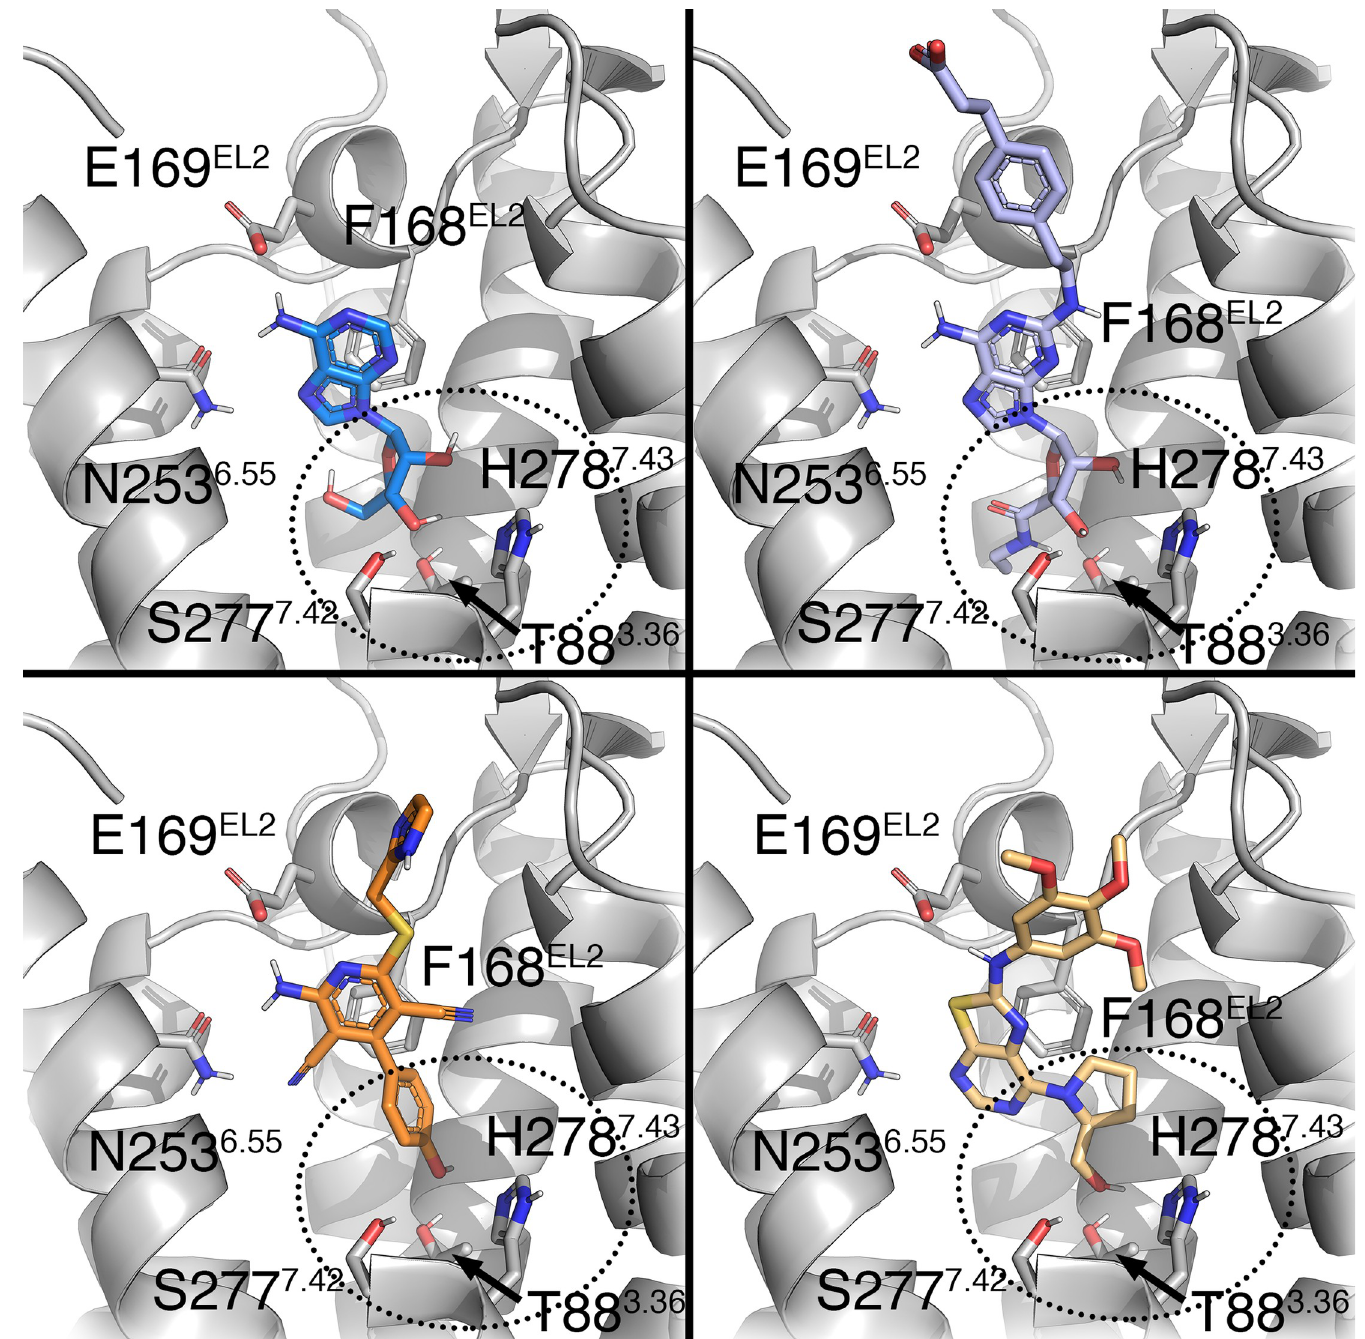
Fig 3. Binding mode of four adenosine A 2A AR agonists with different efficacies. (A, B) Top panels show the experimental pose of full agonists adenosine (A, PDB code 2YDV [31]) and CGS21680 (B, PDB code 4UG2 [13]). (C, D) Bottom panels show the docking model obtained for partial agonists LUF5834 (C) [29] and 10n (D) [28]. The key residues common for ligand-receptor interactions (N253 6.55 , E169 EL2 and F168 EL2 ) [18] are shown in sticks. The ribose binding site is denoted in a dotted circle, with interacting residues associated with ligand activation shown in sticks.